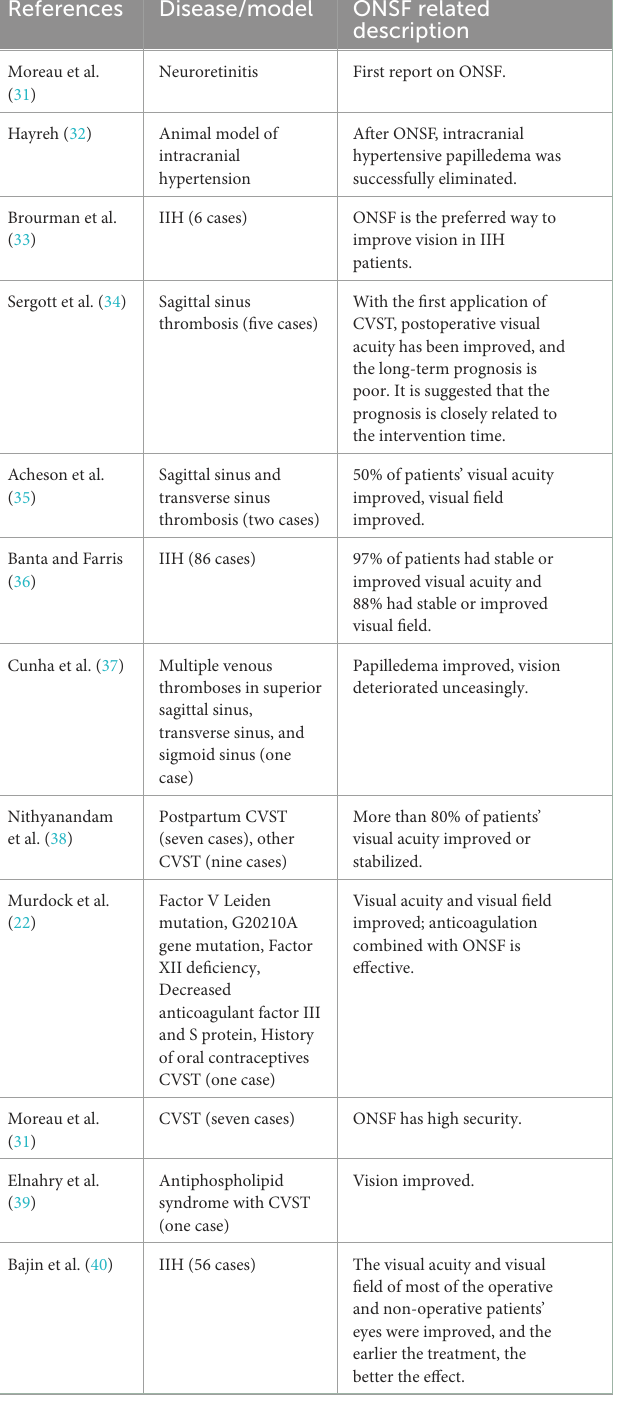
TABLE 1 History of development of ONSF for intracranial hypertension.